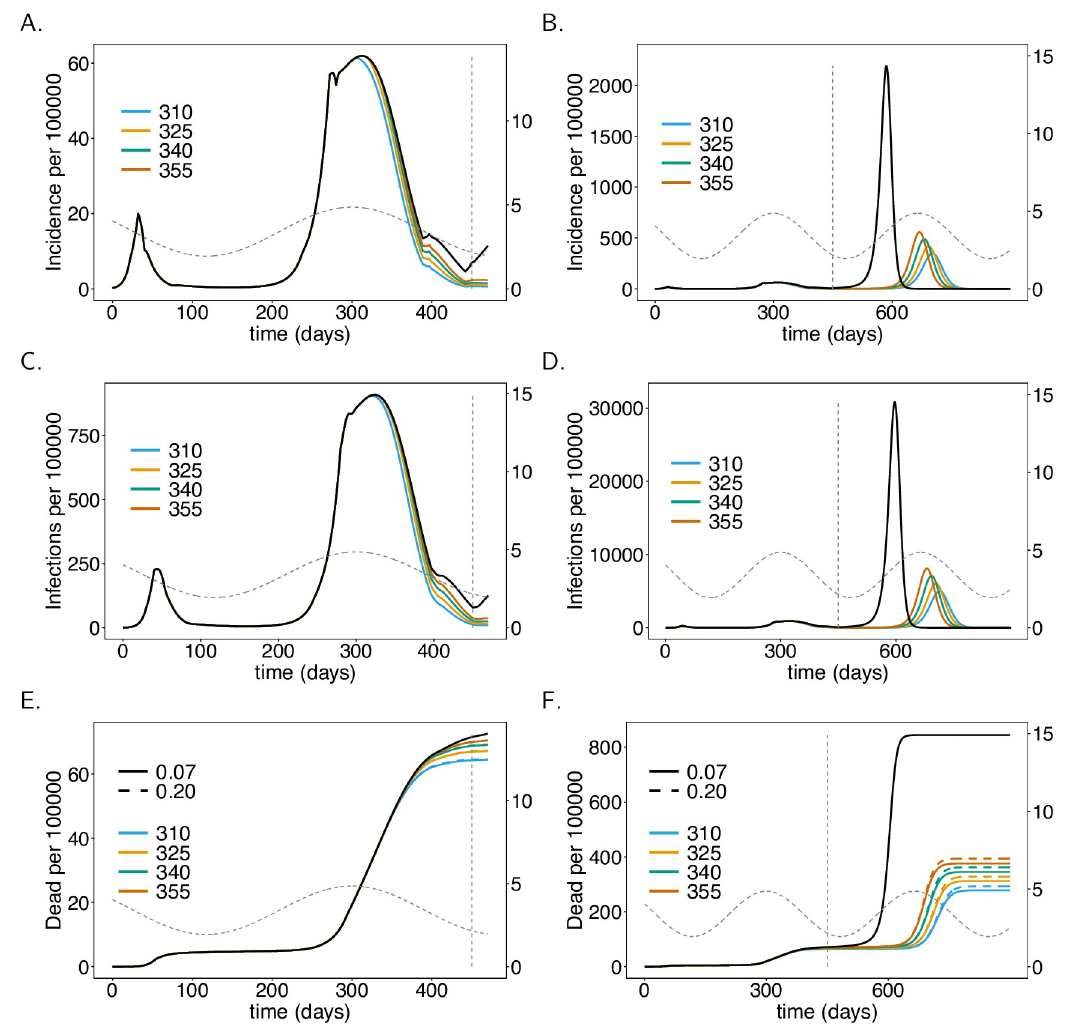
Fig 4. Onset of the vaccination campaign. Plots show (total) incidence (panels A-B), prevalence per 100000 individuals (panels C, D), and mortality, i.e., the cumulative deaths ( D ), per 100000 individuals (panels C, D) as a functions of time t for different onsets of the vaccination campaign (colors). In panels E and F the effect of increased ADE-induced mortality is shown (dashed lines ¼ 20% vs . solid lines f ¼ f ð ADE Þ ¼ 7% ). (Note the values of f ð ADE Þ only affects mortality, not incidence.) As a baseline f ð ADE Þ Dead Dead Dead Dead comparison, the black lines show incidence and mortality in the absence of the vaccine. The vertical dashed line indicates time t = 450 at which contact reductions are lifted. Seasonal fluctuations in R 0 are shown by the grey dashed lines corresponding to the y-axis on the right-hand side. Plot parameters are given in S1–S3 Tables.